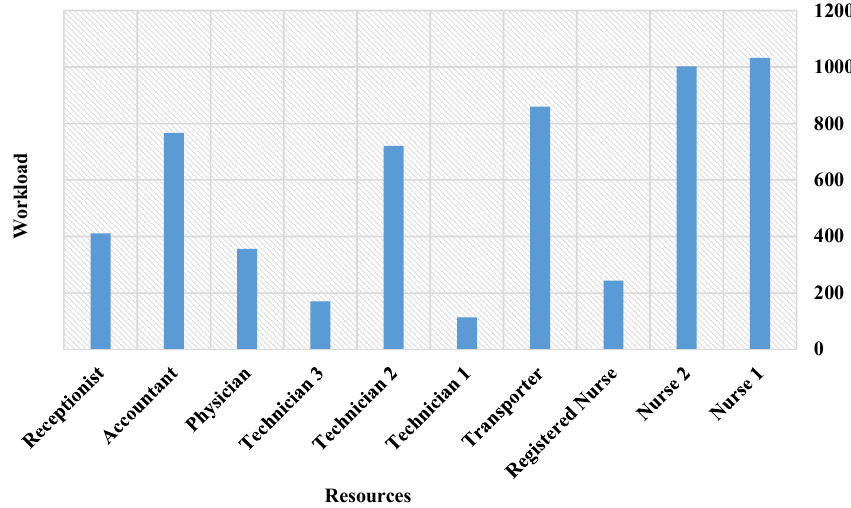
Figure 12. Resources